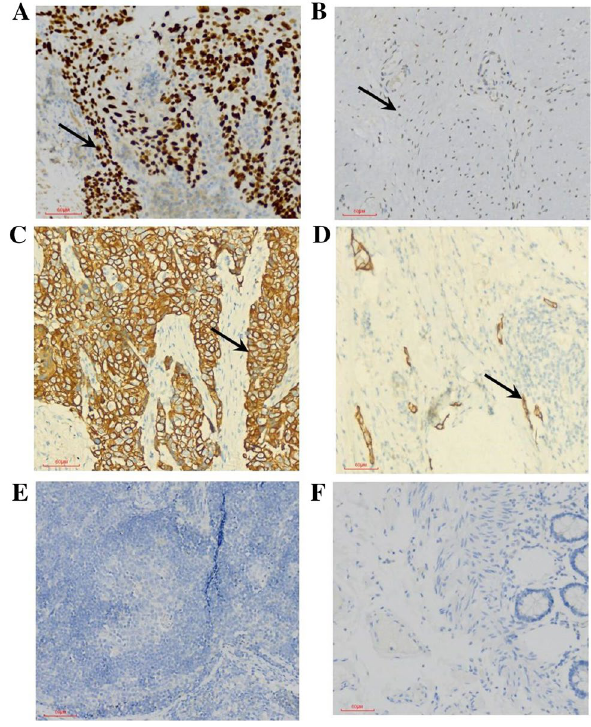
Fig. 1 IHC: Comparative HMGB1 and RAGE expres- sion patterns in the tumor esophageal tissue (ESCC) and adjacent esophageal tissue. A Positive staining for HMGB1 in the ESCC group. B Positive staining for HMGB1 in the adjacent tissue group. C Posi- tive staining for RAGE in the ESCC group. D Positive stain- ing for RAGE in the adjacent tissue group. E , F Negative control of two groups. The arrow points to the positive cells. Magnification: